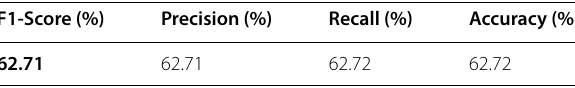
Bold values indicates the top-performing models